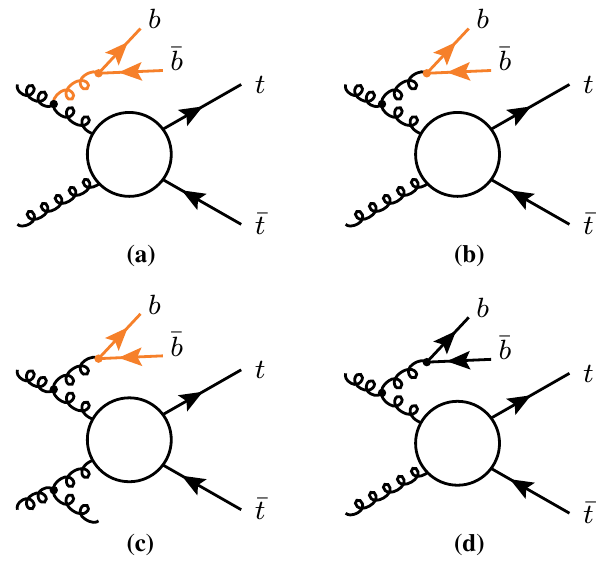
Fig. 2 Sample diagrams describing the interplay between matrix ele- ments(black)andpartonshower(orange)for t ¯ t + b -jeteventsinmerged LOPS simulations of t ¯ t + 0 , 1 , 2jet production in the 5F scheme. In regionswherethe b ¯ b systemanditsparentgluonareproducedbelowthe merging scale, the event is described through hard t ¯ t matrix elements plus parton-shower branchings ( a ). When the parent gluon becomes harder, the parton shower is used only to model collinear g → b ¯ b split- tings ( b ). Above the merging scale, if g → b ¯ b splittings do not belong to the two hardest branchings they are still left to the parton shower, while 2 → 4 matrix elements are used to account for other light jets ( c ). Otherwise, the event is described through t ¯ tb ¯ b matrix elements ( d